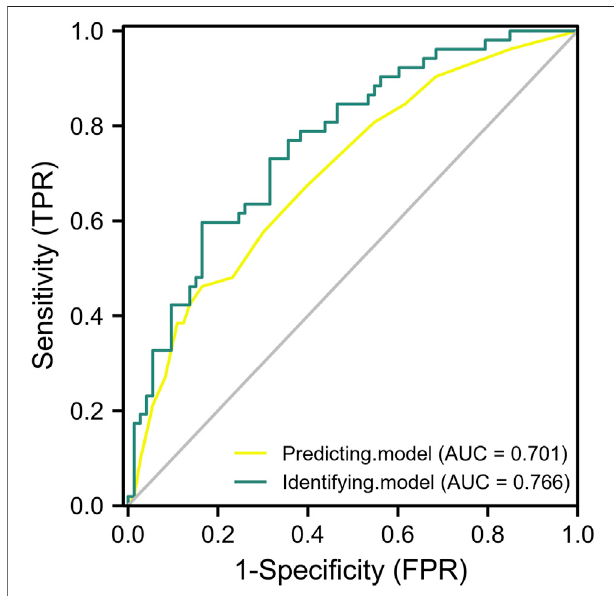
FIGURE 3 | The ROC analysis of predictive and identifying models for cross validation. The yellow curve: the ROC curve of predictive model only including three SNPs. The green curve: the ROC curve of identifying model including three SNPs, BMI, and SVJ.